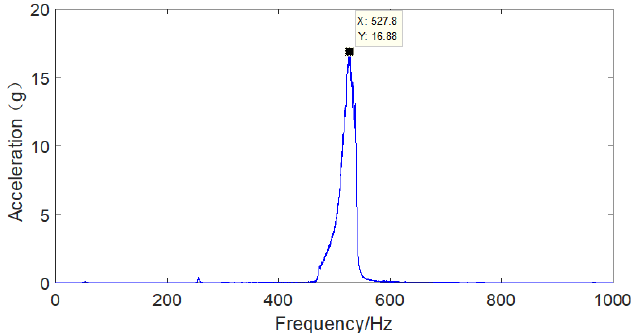
Figure 24. Frequency sweep vibration response of galvanized iron clamp with a 200- μ m-thick hard coating of Al-Cu-Fe-Cr.